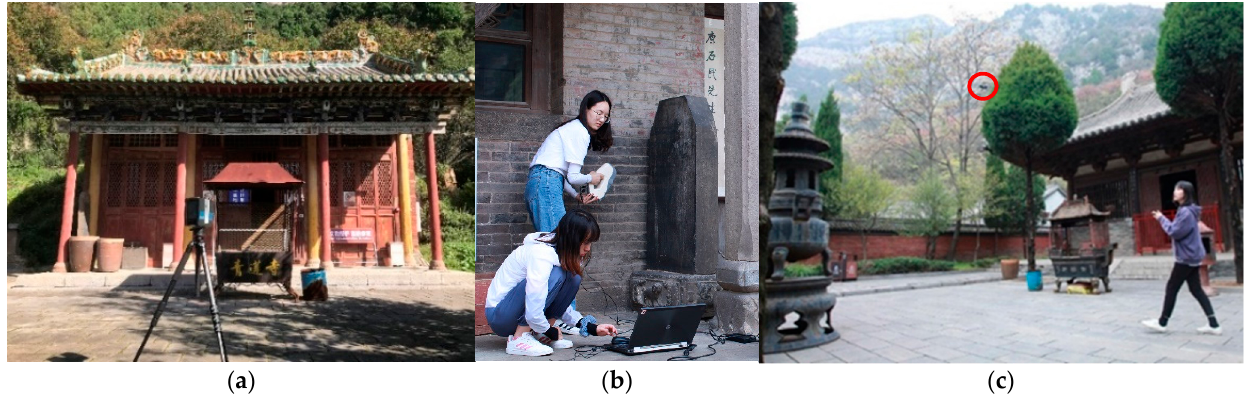
Figure 8. Data collection: ( a ) terrestrial laser scanning, ( b ) handheld scanning, and ( c ) UAV photogrammetry. togrammetry.